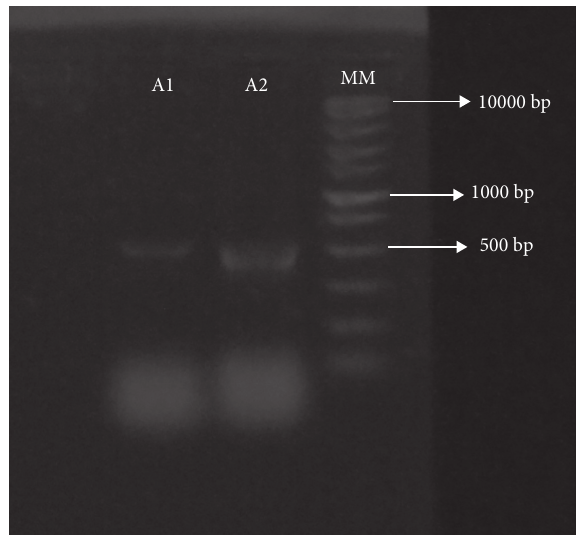
Figure 3: Amplification by PCR. MM � molecular (Fast DNA Ladder), A1 and A2 represent the amplified fragments of 562bp and 530bp,